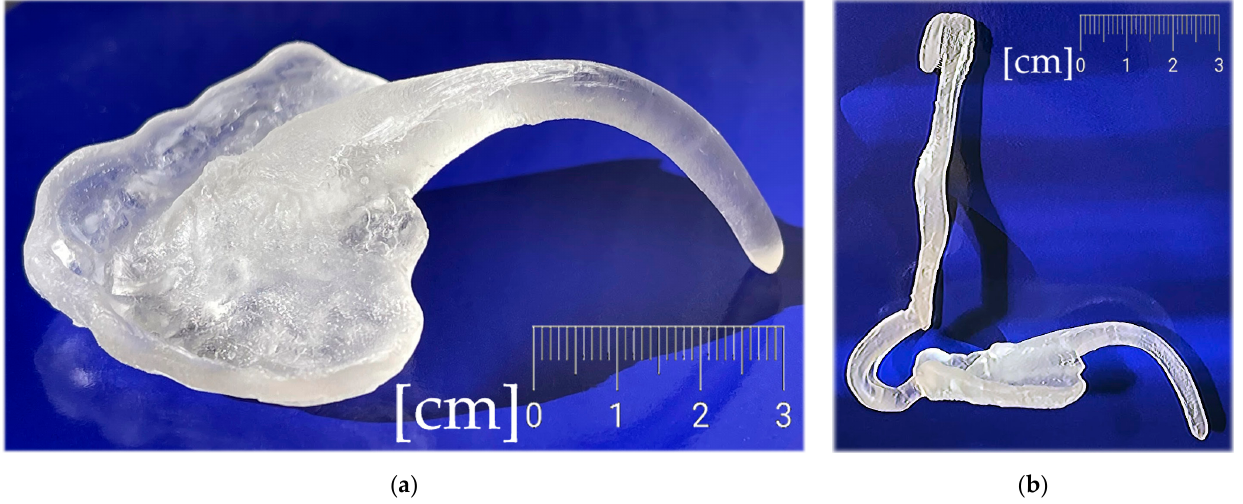
Figure 21. The final appliance after additive manufacturing and post-processing, printed from Dental LT Clear V2 (Formlabs, Somerville, MA, USA): ( a ) the intraoral part; ( b ) complete.